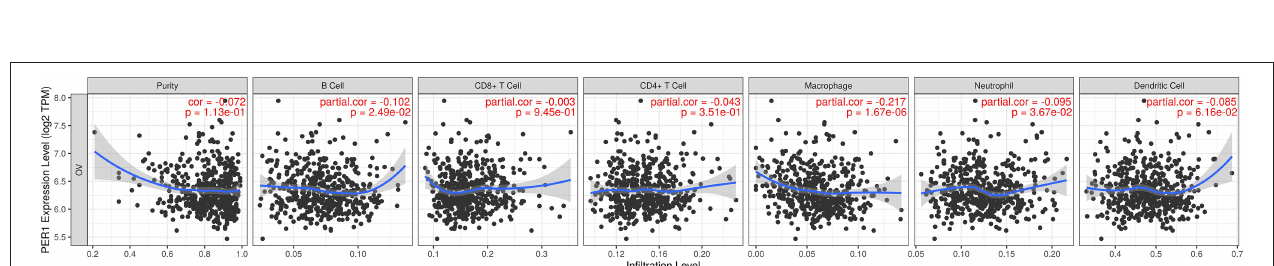
FIGURE 6 | Correlation of PER1 expression with immune infiltration levels in OV. PER1 expression was significantly negatively related to infiltrating levels of macrophages, neutrophils, and B cells.